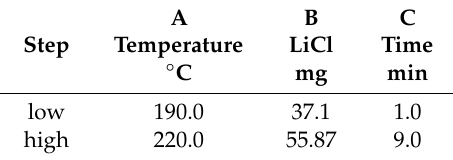
Table 3. Factor steps of the second experimental plan.